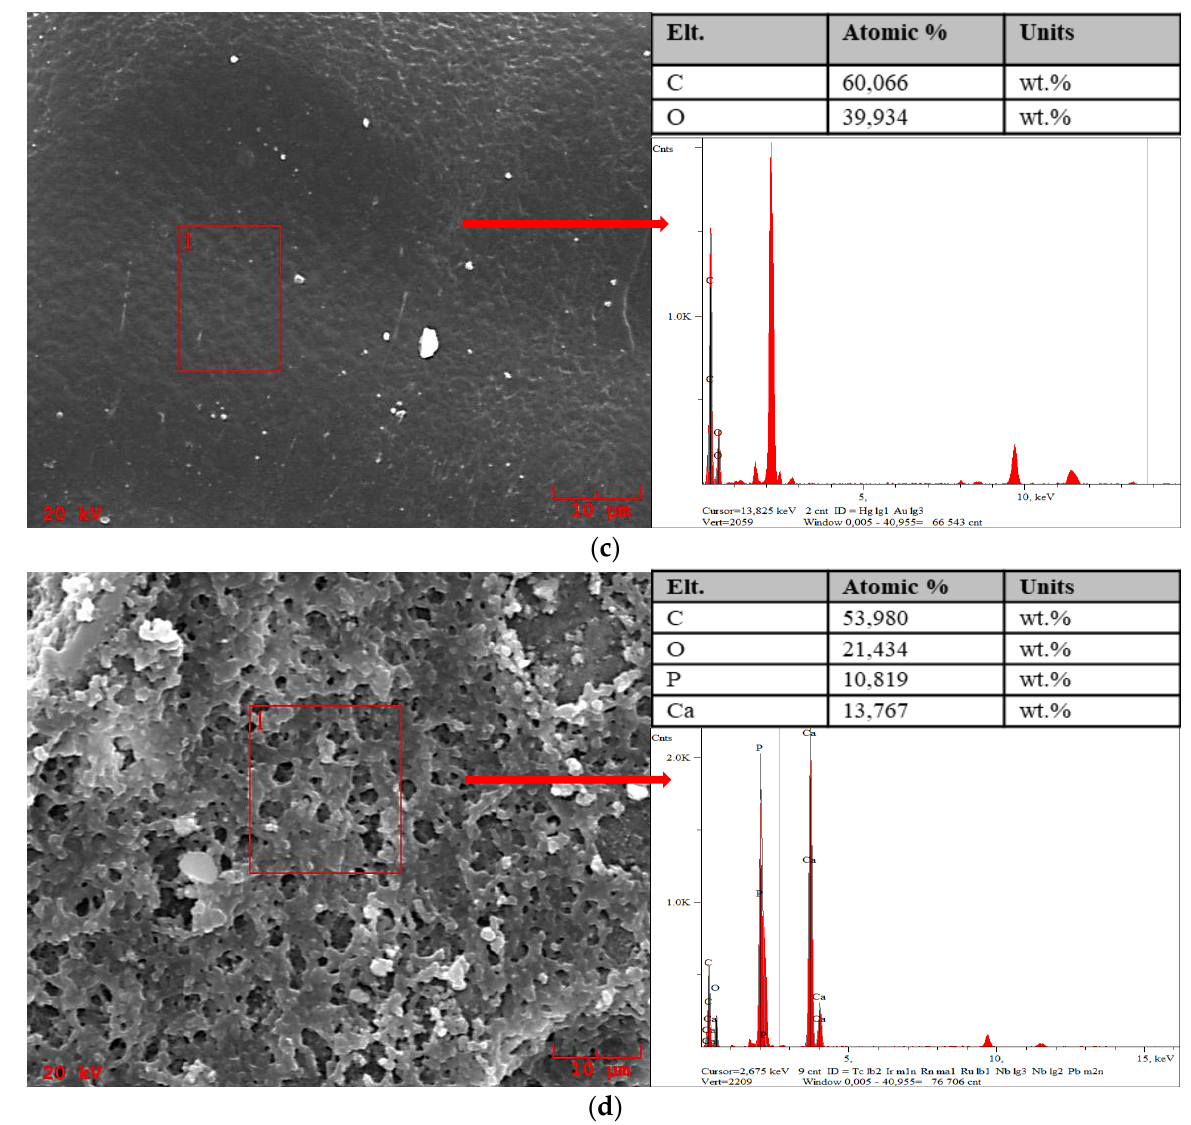
Figure 8. SEM-EDS analysis of sample 575 ( a ), 575_HAp ( b ), 700 ( c ) and 700_HAp ( d ).